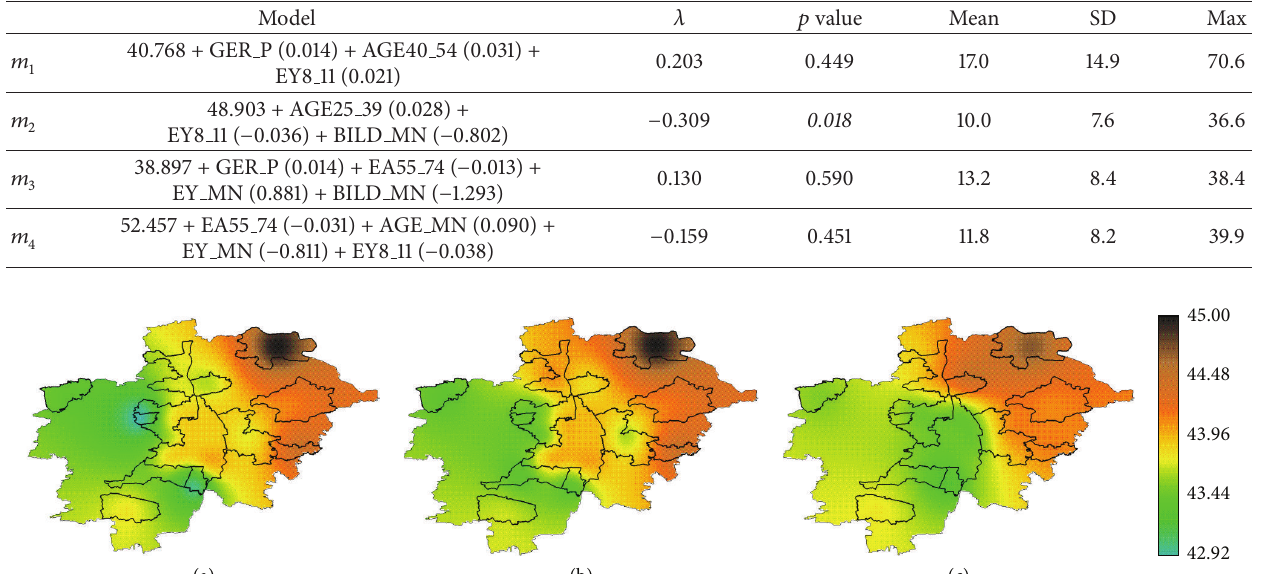
Figure 6: Landscapes estimating the genetic variation in the study area (a) 𝐻 𝑂 ( ALL ) : observed heterozygosity of the total sample (officially registered German citizens); (b) 𝐻 𝑂 ( GER ) observed heterozygosity of the native data set (individuals born in Germany); (c) predicted heterozygosity according to the best-fit spatial autoregressive model (Table